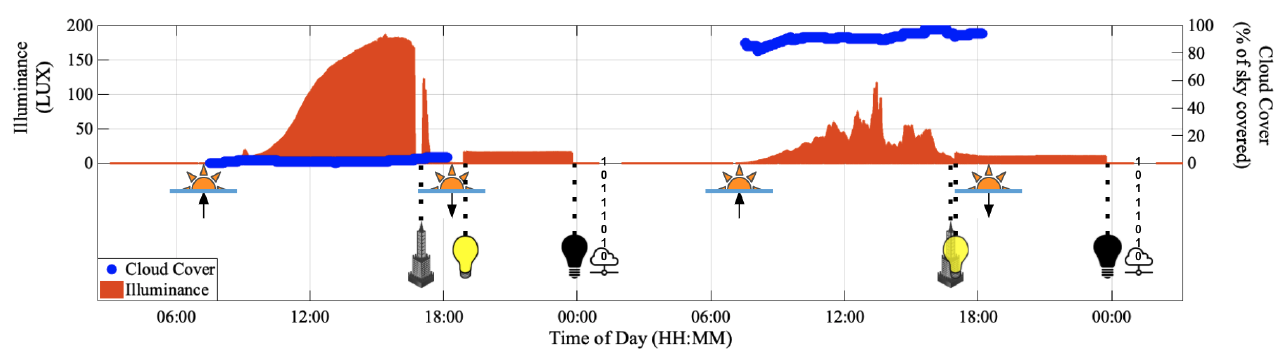
Figure 5. Observing the effects of cloud cover, sunrise, sunset, lights-ON, lights-OFF and buildings around the data collection site on the ambient light in a built environment for two continuous days (48 h). The solid-orange bars ( ) depict the amount of ambient light sensed by the color sensor in Lumen per square meter (LUX). The solid-blue circles ( ) depict the local cloud cover in percentage of local sky covered by clouds. The sunrise and sunset times are indicated with the rising and setting sun symbols, respectively, using the upward and downward arrows. The yellow and black bulbs specify the lights-ON and lights-OFF times, respectively. The skyscraper symbol indicates the time when the Sun goes behind a skyscraper and causes a shadow onto the location where ambient light was being tracked. Data upload is depicted by binary values and a cloud